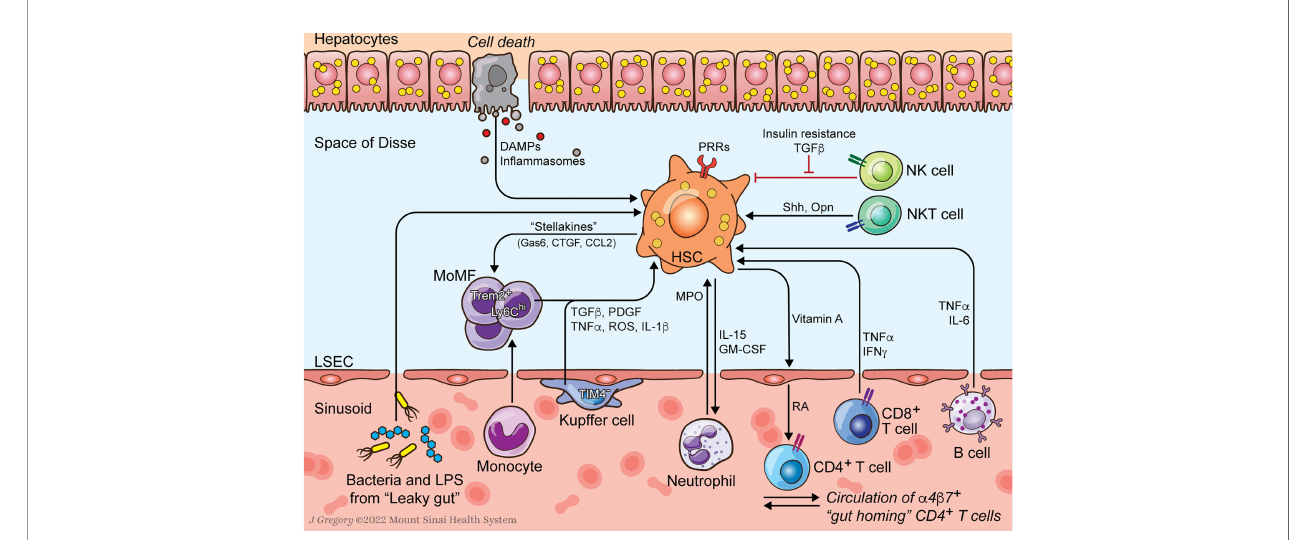
FIGURE 1 | HSC-Immune Interactions in NASH Progression. Communication between hepatic stellate cells (HSCs) and immune cells amplify pro fi brogenic in fl ammatory signaling in NASH. HSCs respond to damage-associated molecular patterns (DAMPs) and pathogen-associated molecular patterns (PAMPs) that are increased in NASH. Resident Kupffer cells (KCs) and recruited monocyte-derived macrophages (MoMFs) release cytokines that promote HSC activation and survival. Neutrophil myeloperoxidase (MPO) is directly activating to HSCs which secrete factors to prolong neutrophil survival. HSCs supply vitamin A to the sinusoidal niche where it is converted to retinoic acid (RA) by liver sinusoidal endothelial cells (LSECs) as an important signal to immune cells including a 4 b 7 integrin positive gut homing CD4 + T cells. Lymphocytes, including B and CD8+ T cells, release HSC-activating cytokines like TNF a and IL-6. Natural killer T (NKT) cells promote HSC activation through release of osteopontin (Opn) and sonic hedgehog (Shh). Natural killer (NK) cells display reduced HSC killing due to increased insulin and TGF b